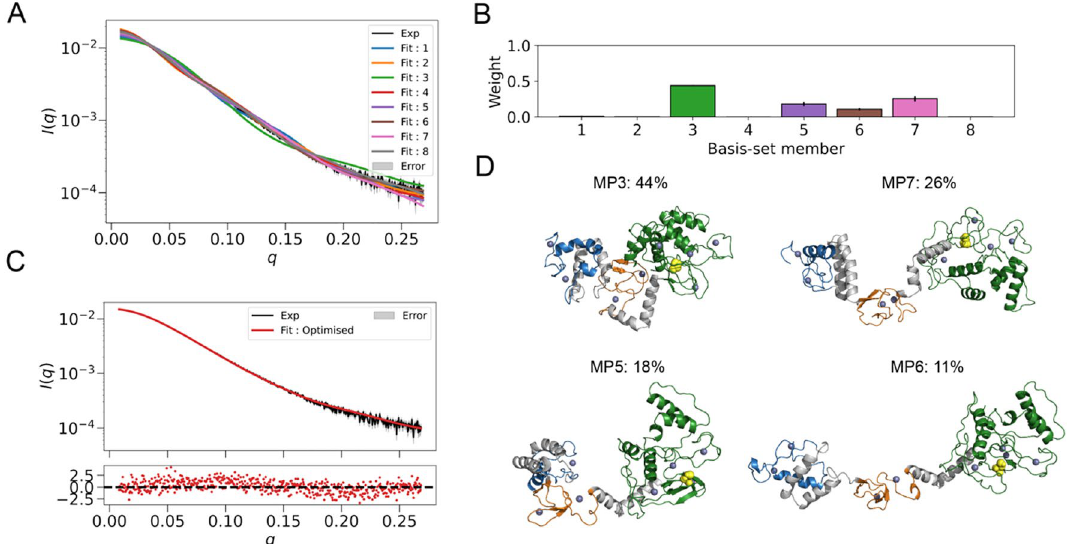
Figure 4. MaxPars ensemble modelling of the HOIP RBR domain. ( A ) Scattering profiles of basis-set members. ( B ) Populations of individual basis-set members, where error bars are standard deviation of the sampled posterior distribution. ( C ) Agreement between experimental and MaxPars ensemble scattering profiles. The experimental and MaxPars scattering profiles are coloured black and red, respectively. Experimental error is denoted in grey. The error-weighted residuals (I∆)/σ exp = [I exp (q) − I ensemble (q)]/σ exp versus q are plotted below. ( D ) Top 4 basis-set members with individual weights represented as percentages. RING1, IBR, RING2 and linkers are coloured in blue, orange, green and grey, respectively. The catalytic cysteine C885 is shown as yellow spheres. Zn +2 ions are shown as dark blue spheres. For an overlap of members in two different orientations see Supplementary Fig.